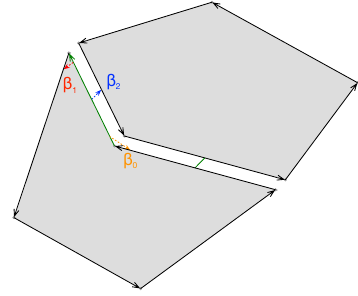
Figure 1. An example of a 2D C-Map. Darts are denoted as black arrows. A dart is highlighted with green color and its β i pointers are